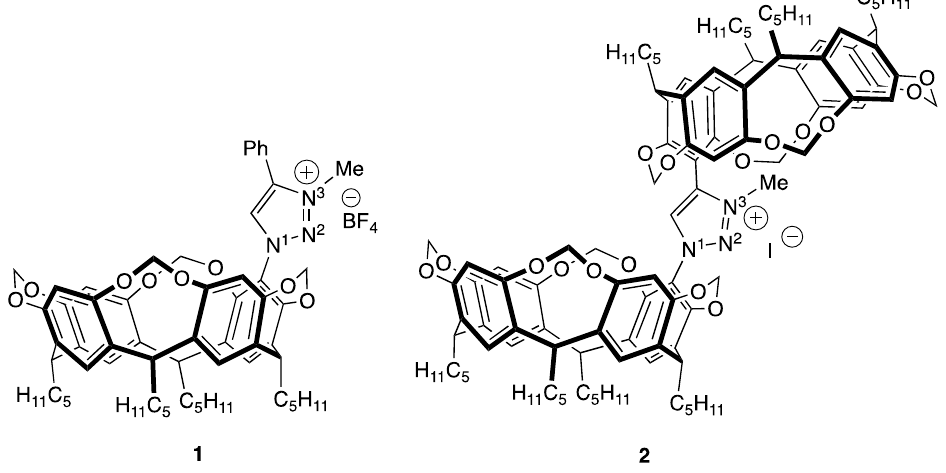
Figure 1. The resorcinarenyl-substituted triazolium salts used in this study.